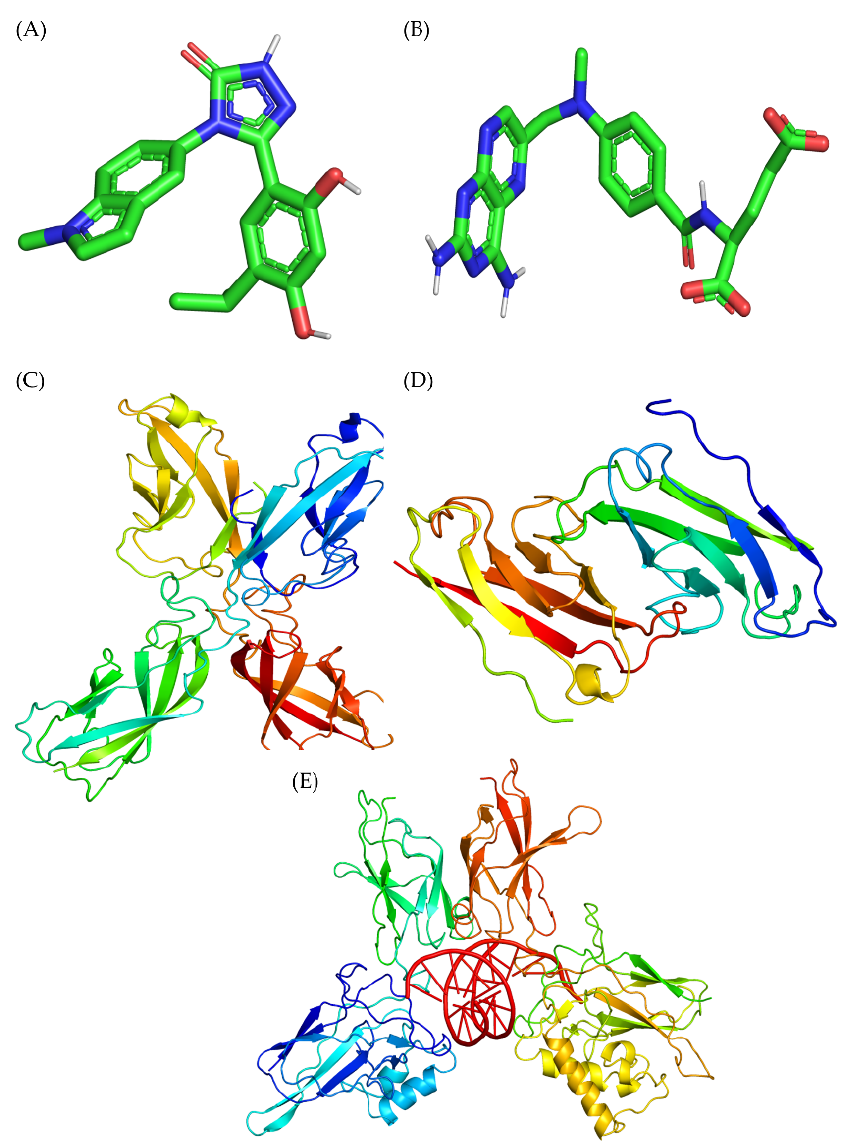
Figure 6. Three-dimensional chemical structures of ( A ) GAN, ( B ) MTX, ( C ) E-cadherin, ( D ) N-cadherin, and ( E ) NF- κB/p65.